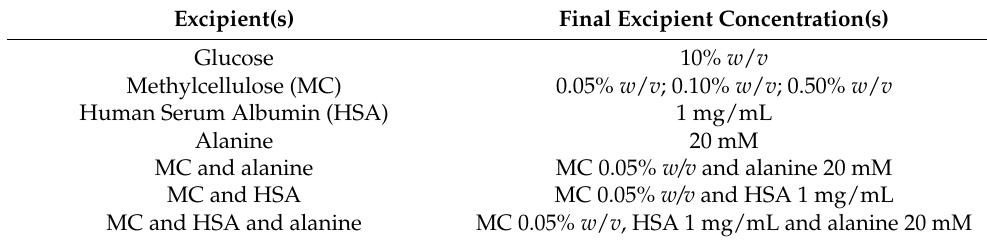
Table 2. Composition of potential FGF-2 stabilisation vehicles.